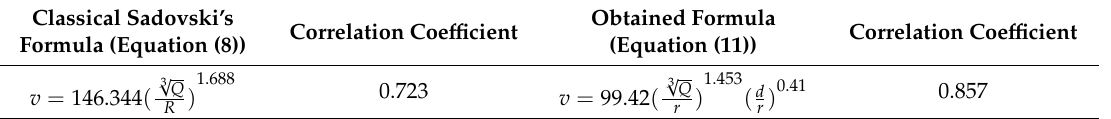
Table 4. Prediction formulas of peak particle velocity (PPV) on the ground